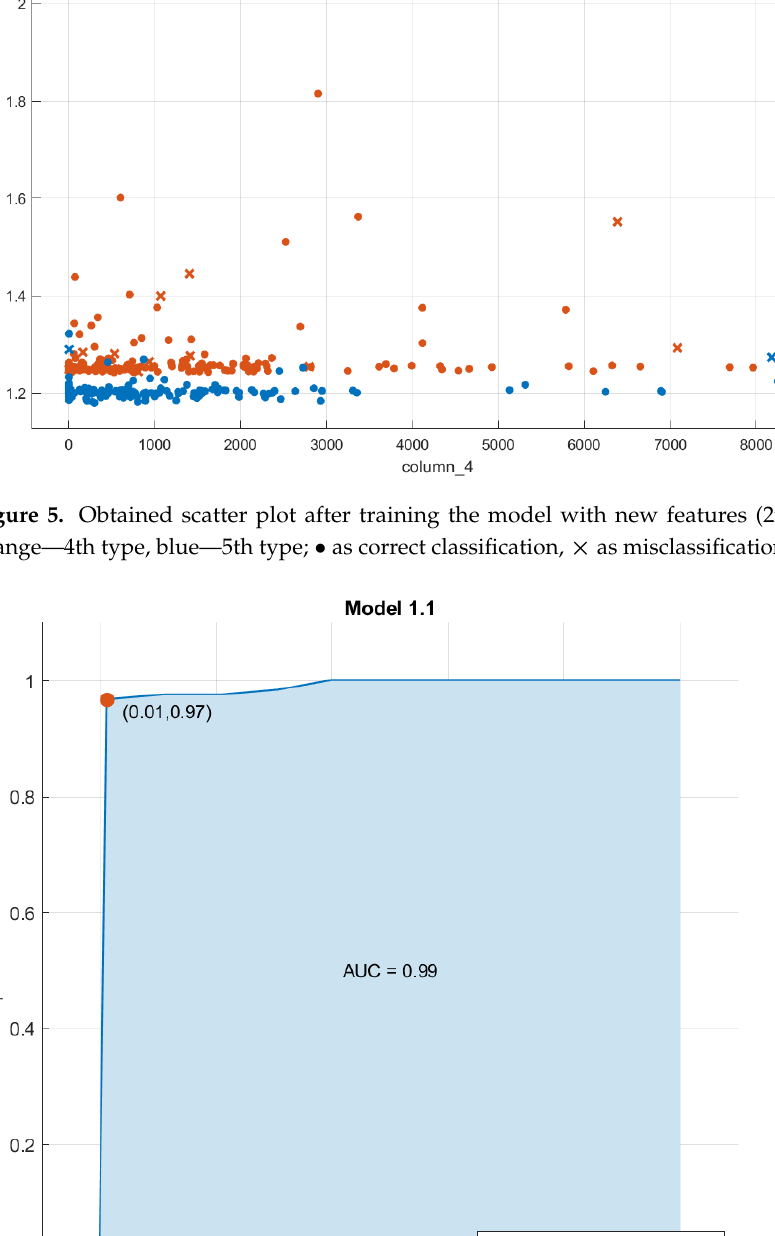
Figure 4. Obtained scatter plot after training the model with new features (1st group of data; yel-